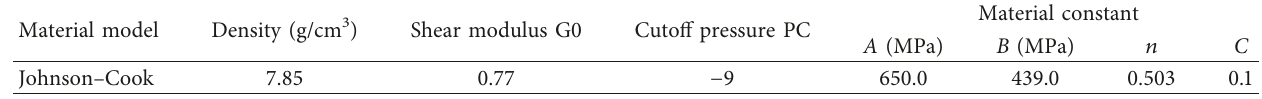
Table 6: Q235 material parameters.